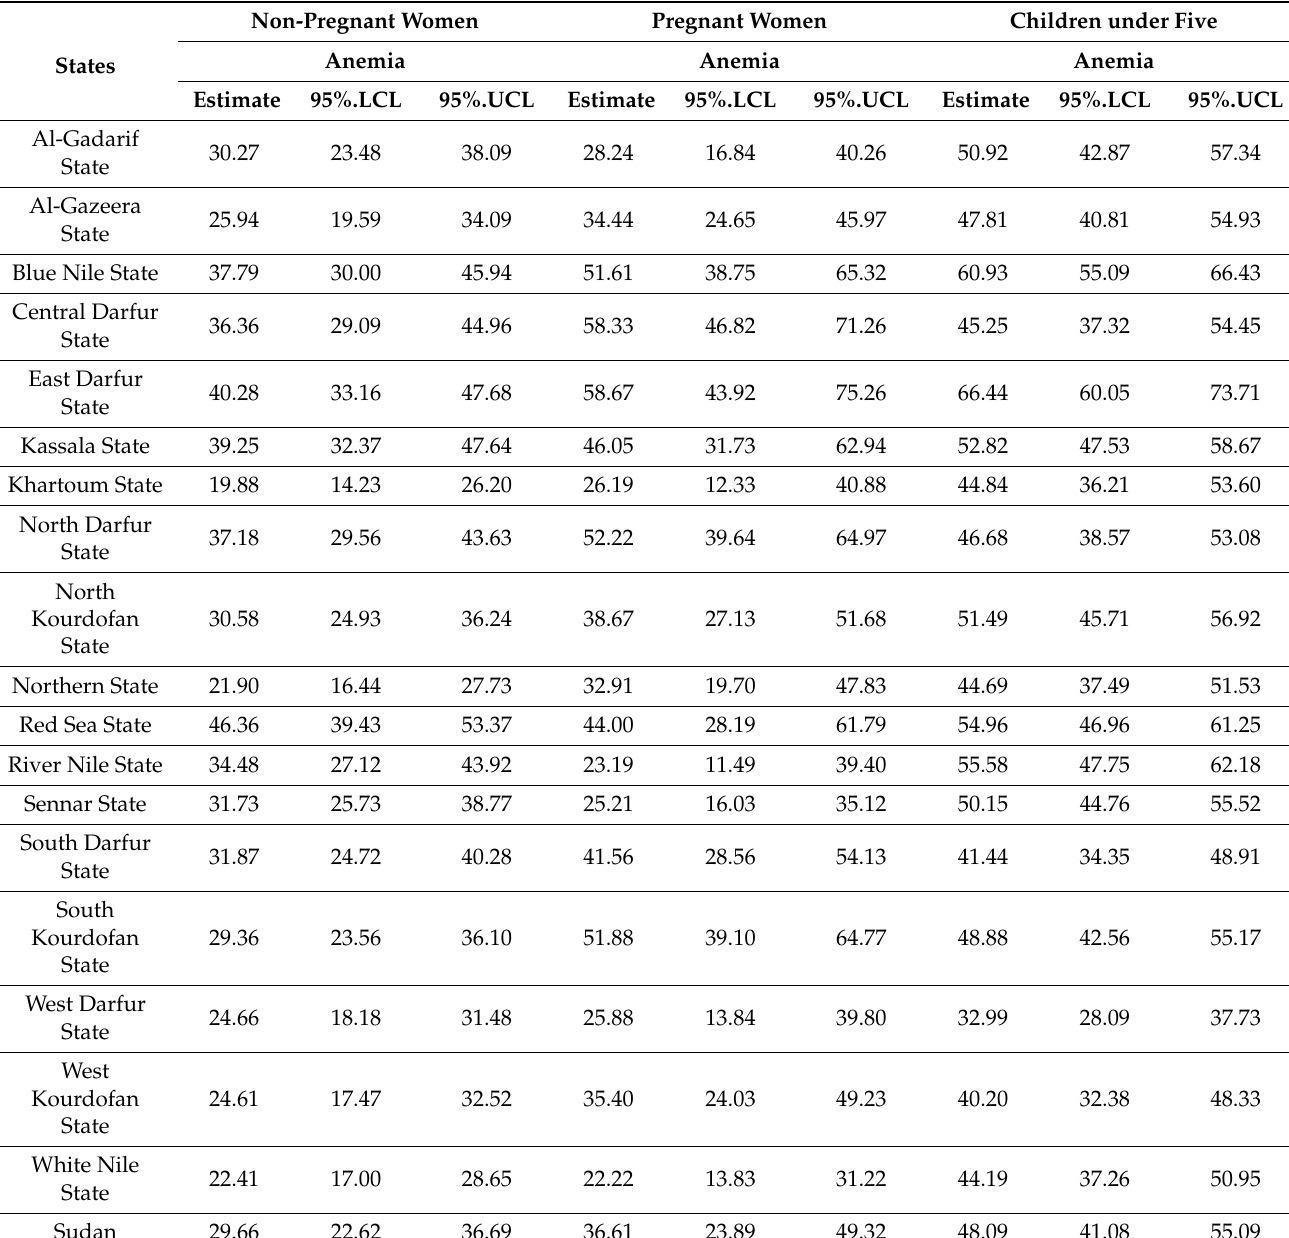
Table 7. An estimation of median adjusted serum hemoglobin concentration (g/dL) and prevalence of any anemia (%) among reproductive-age women (15–49 years of age) and their